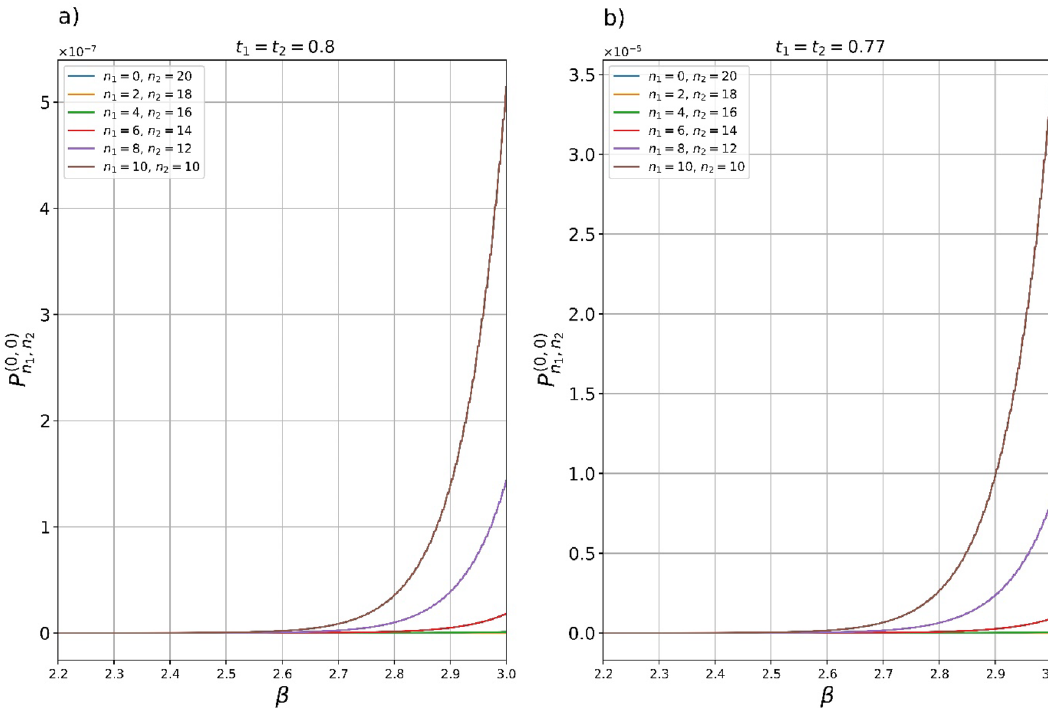
( 0,0 ) y 20 (β) Figure 4. ( a , b ) Plots of the success probabilities P (Eq. (6)) to generate even SCSs with the fidelity n 1 , n 2 presented in Fig. 2a on output of the hub with two BSs and PNR detectors in the dependency on the SCS (cid:31) (cid:30) 0.8 and b) t 2 amplitude β . The plots are constructed for different BSs transmittance coefficients: ( a ) t 1 = = 0.77 . Detection of only even photon states n 1 2 m 1 and n 2 2 m 2 is considered. The maximum t 1 t 2 = = = = ( 0,0 ) 10 and n 2 10 . Moreover, the probability is several y 20 (β) possible probability P is observed when n 1 10,10 = = ( 0,0 ) orders of magnitude higher than the probability P 0,20 (cid:31) (cid:30) of generating SCS in a scheme with one BS and PNR detector . Transmission of more photons into the measurement modes ( b ) makes it possible to increase the success probability by almost two orders of